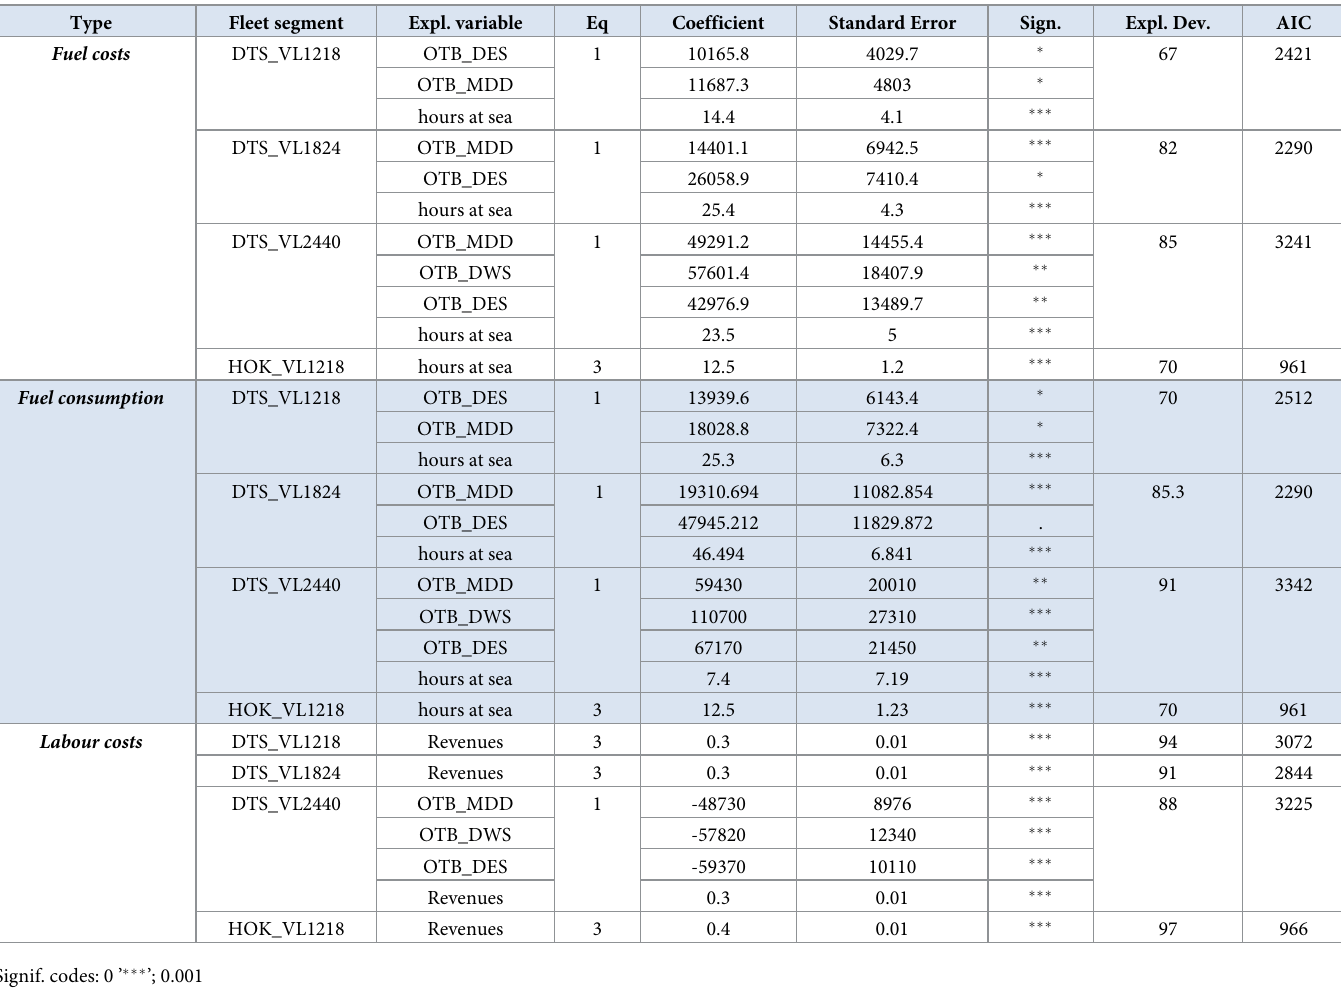
Table 3. Summary of results of the GLMs by fleet segment and me´tier. The results of the best performing option are reported for each cost type and fleet segment. Type